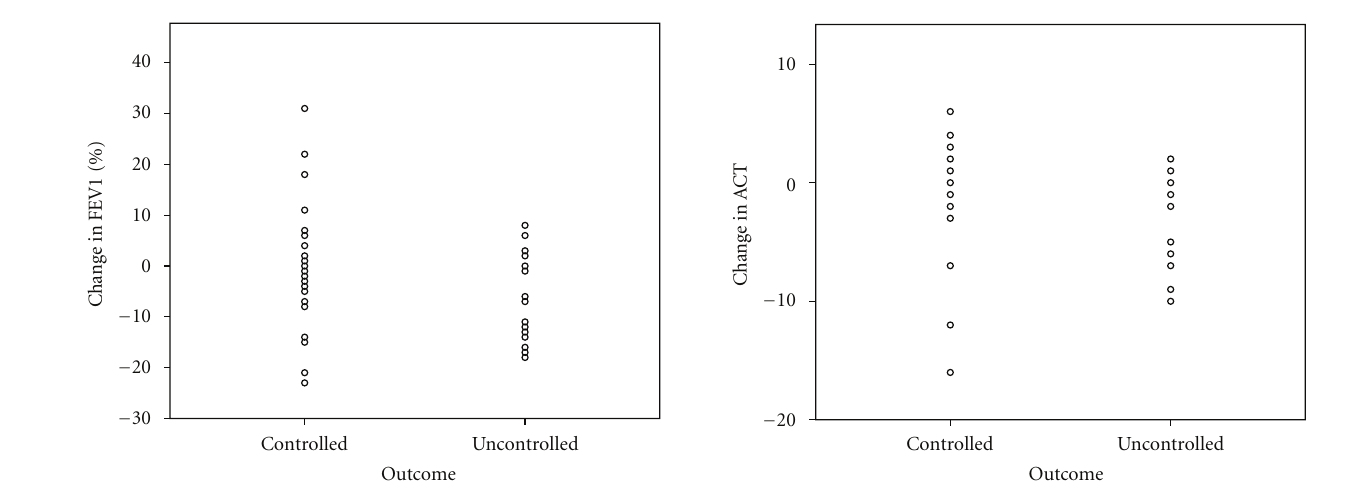
Figure 1: Scatterplot showing patient’s change in FEV 1 (% predicted) comparing those that maintained asthma control o ff LABA therapy at followup (controlled) and those that experienced loss of asthma control (uncontrolled).